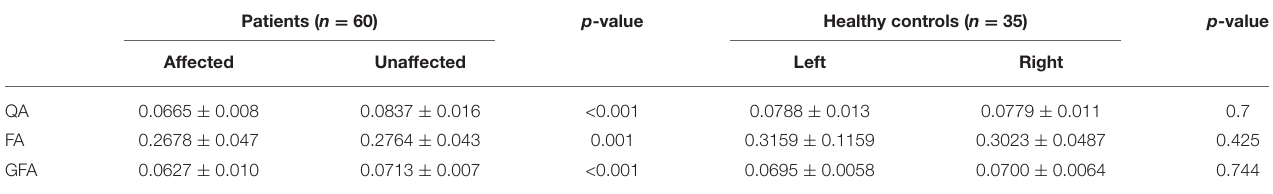
TABLE 2 | Compared with the sides of the affected and unaffected patients and the healthy control group left and right. Patients ( n = 60) p -value Healthy controls ( n = 35) p -value